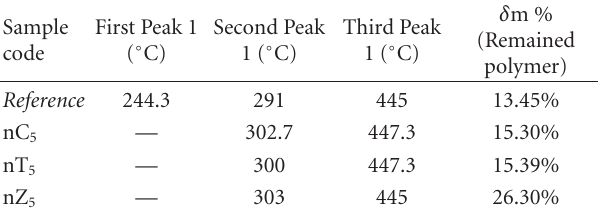
Table 5: Thermal analysis data of composites obtained by